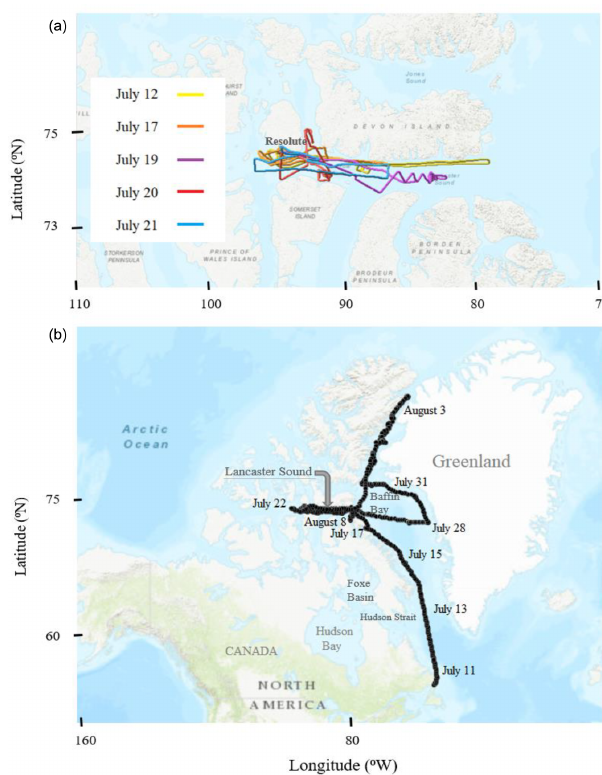
Figure 2. The Polar 6 (a) and Amundsen (b) trajectories during July 2014. The base maps in this figure were created using online ArcGIS ® by Esri.